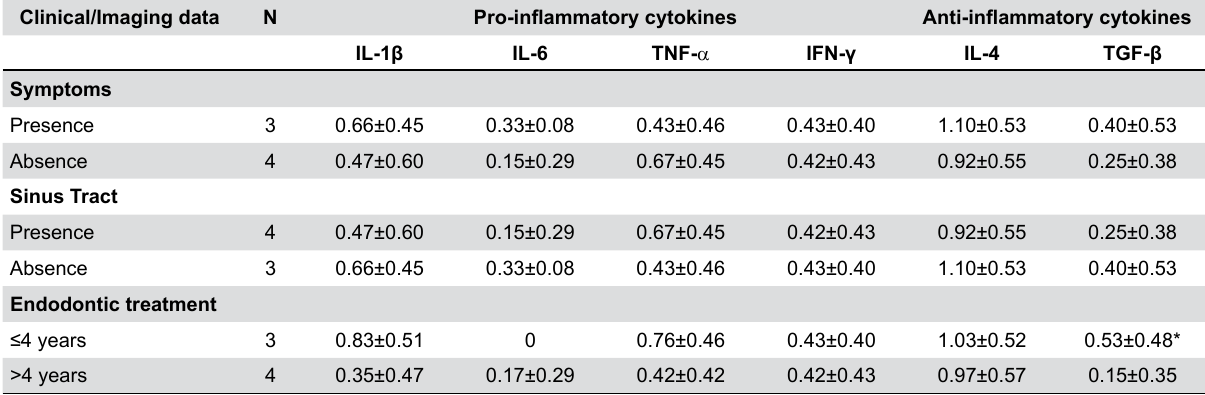
Table 4- Comparison between pro-inflammatory and anti-inflammatory cytokine expression and clinical and imaging data in periapical cysts